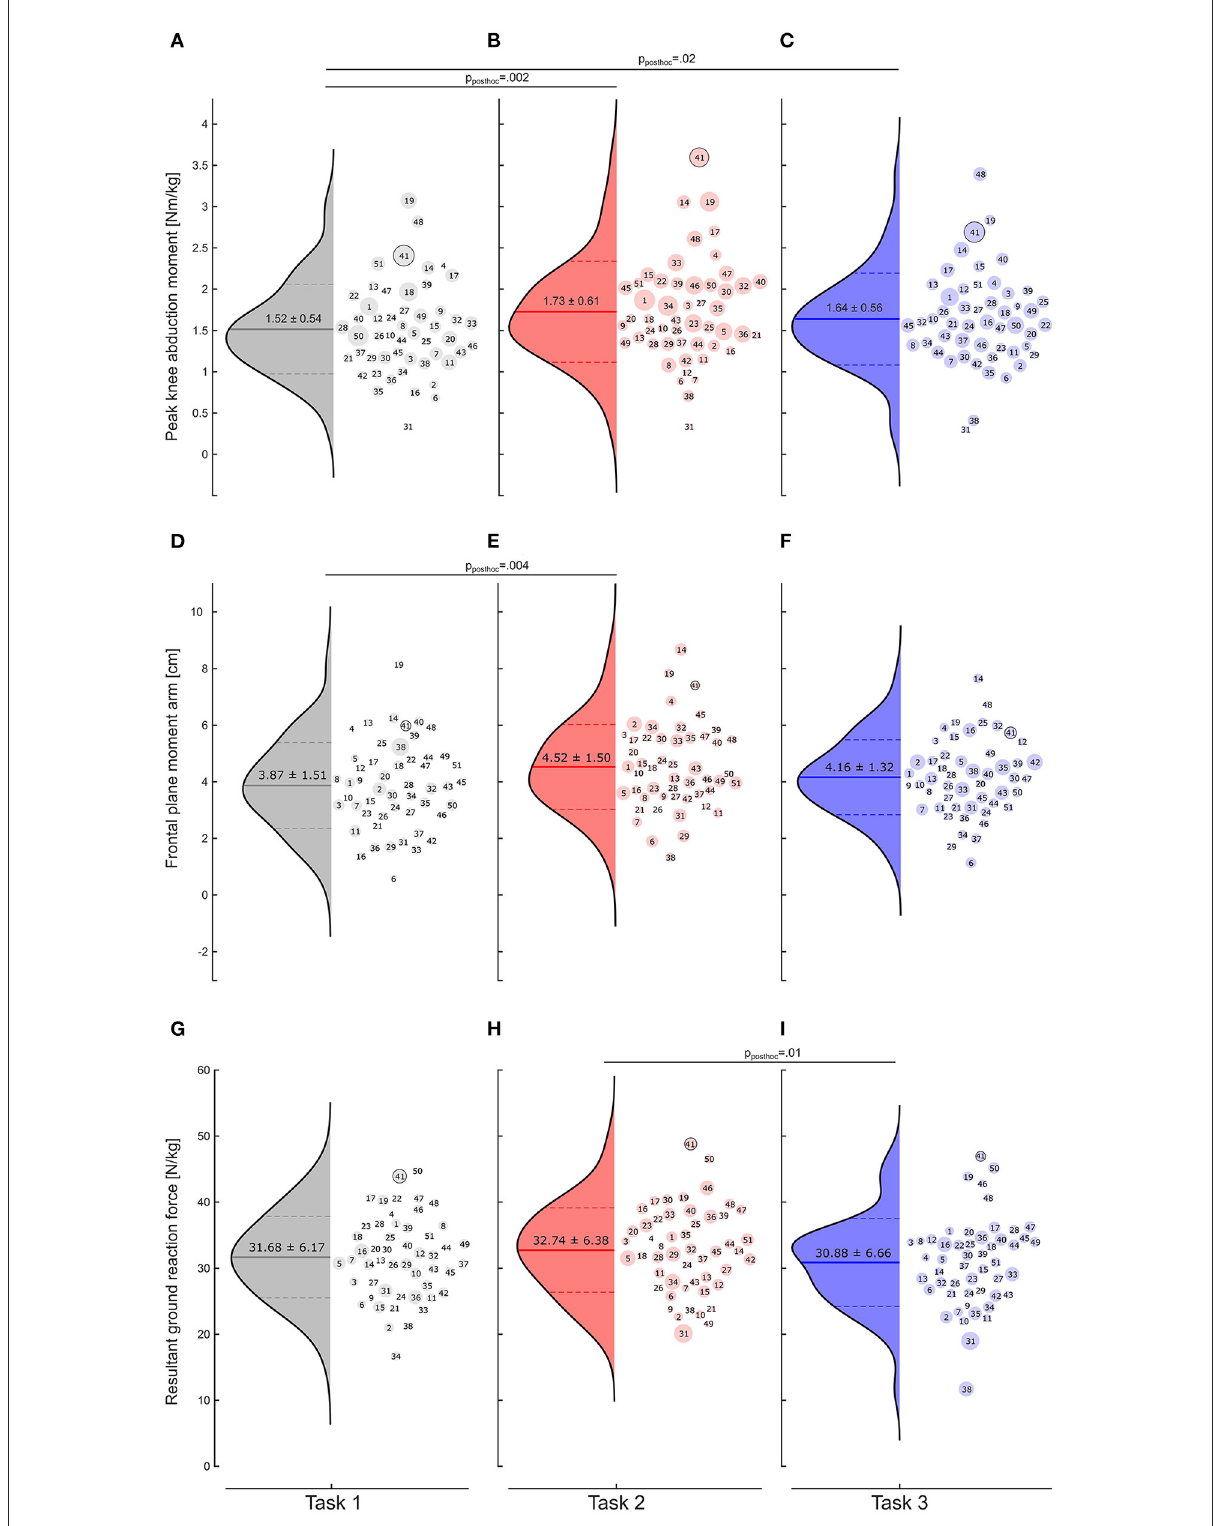
FIGURE2 Distribution of the peak knee abduction moment [Nm/kg] within the first 100ms after initial contact for task 1 (A) , task 2 (B) , and task 3 (C) . Bold lines within the distribution curves represent the average peak knee abduction moment, and dashed lines the standard deviations. The diameters of the dots in the scatters are scaled to the individual standard deviation. The player’s number in each scatter helps track the individual rank in each task. (D–F) Distribution of the frontal plane moment arms of the knee joint for the three task complexities; (G–I) Resultant ground reaction forces and peak knee abduction moments for the three task